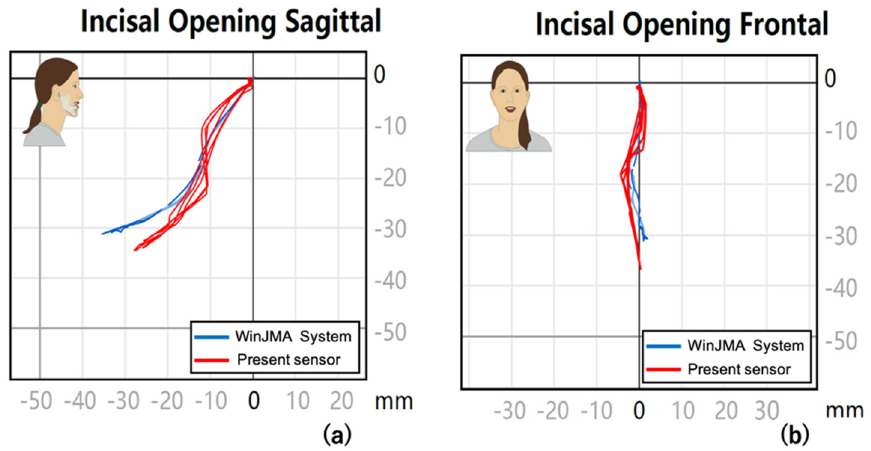
Figure 17. Sagittal and frontal views of the trajectory of jaw movement and trajectory data with simultaneous measurement with the WinJMA System and the present sensor. ( a ) Superimposed trajectories from the sagittal and ( b ) frontal views.